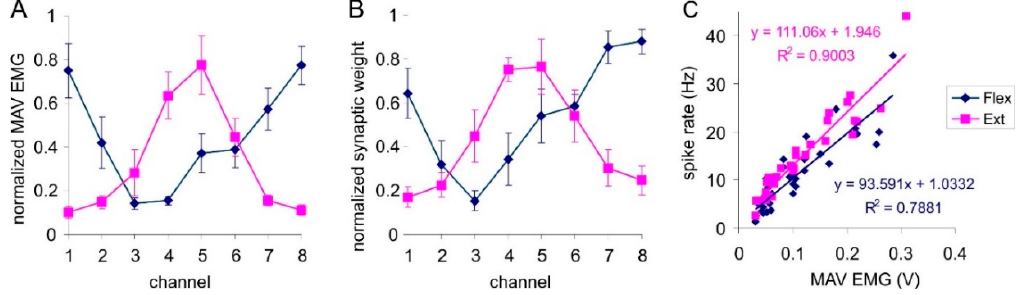
Figure 7. Interrelation of EMG-signal characteristics and neurons-classifiers after learning: ( A ) Average EMG-signal amplitude distribution corresponding to EMG-channel serial number; ( B ) Averaged distribution of synaptic weights corresponding to EMG-channel serial number; ( C ) Relation of spike rate to EMG-signal amplitude.